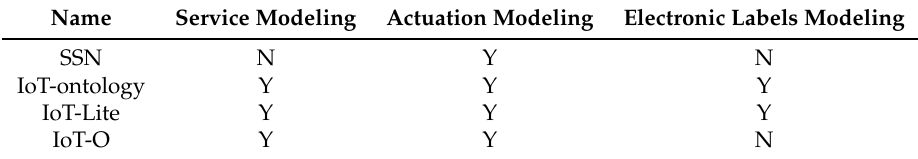
Table 5. Comparison of different ontologies for